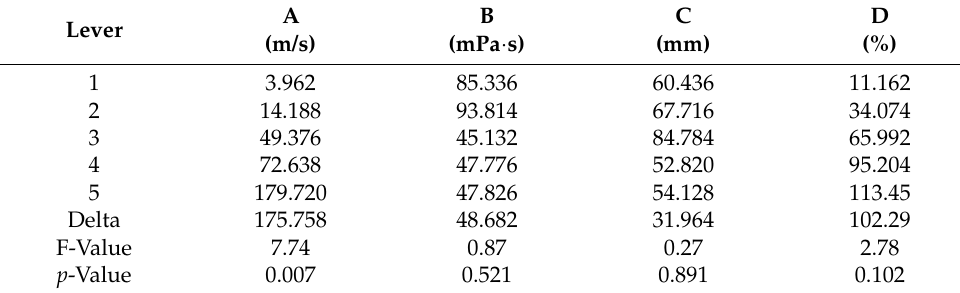
Table 3. Mean response table of influencing